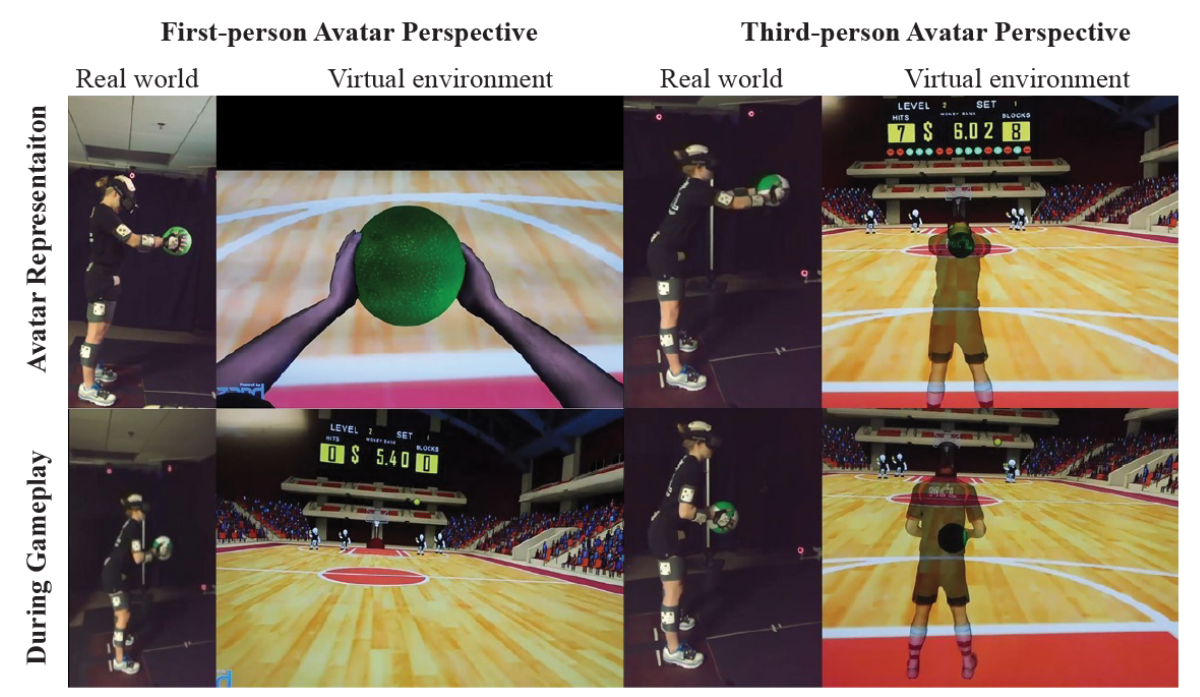
Figure 2. Participant instrumented and engaged in virtual dodgeball using a head-mounted display. Differences in the representation of the avatar in the virtual environment (upper panels) and during gameplay (bottom panels) are shown for both the first-person (left panels) and third-person perspectives (right